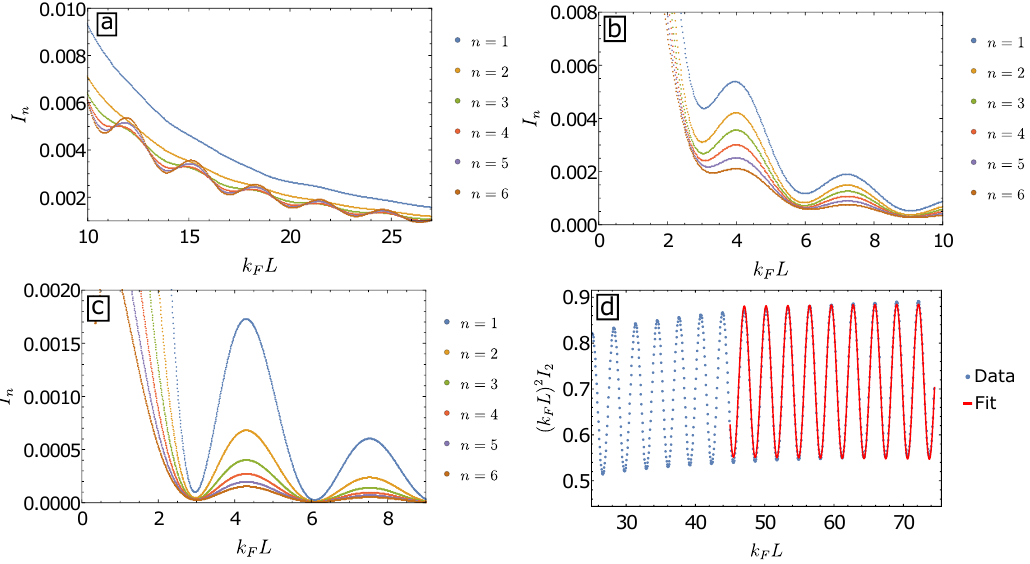
Figure 8 . The subfigures a), b) and c) show simulations of I n ( k F L ) for fixed r for massive Dirac fermions. The parameters are ( k F r, m, m ) = (2 , 1 , 0 . 2); (0 . 5 , 1 , 1); (0 . 2 , 1 , 5) , respectively. k F 500 200 100 We observe Friedel oscillations of period π as a function of k F L , with amplitude dependent on m . In the subfigure d) we check the agreement with (5.14). We fit ( k F L ) 2 I 2 ( k F L ) in the limit k F k F L (cid:29) 1 with m = 1 , k F r = 5 and k F = 1 . The expression used was ( k F L ) 2 I 2 ( k F L ) k F 3 60